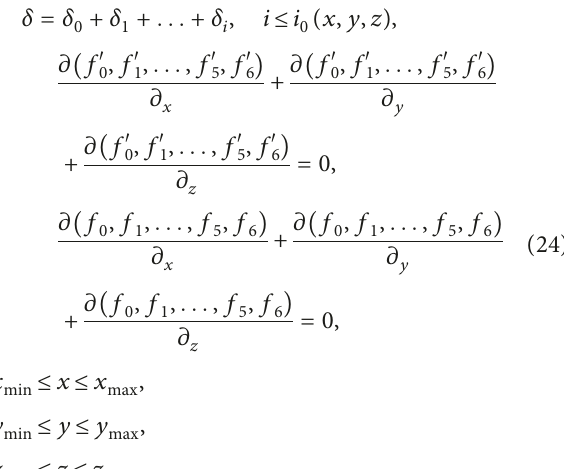
Figure 21: The comparison of original and improved structures. (a) The stress distribution of the original steering support structure, (b) the stress distribution of the improved structure, (c) the torsional stress analysis of the original structure, and (d) the torsional stress analysis of the improved